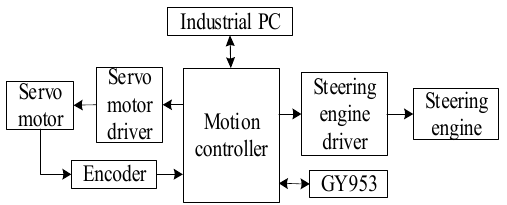
Figure 16. The chassis control system of the greenhouse tomato picking robot.